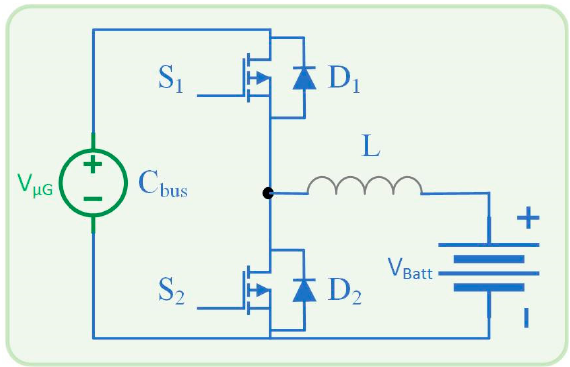
Figure 5. Bidirectional DC–DC converter. Table 1. Bidirectional DC–DC converter parameters.